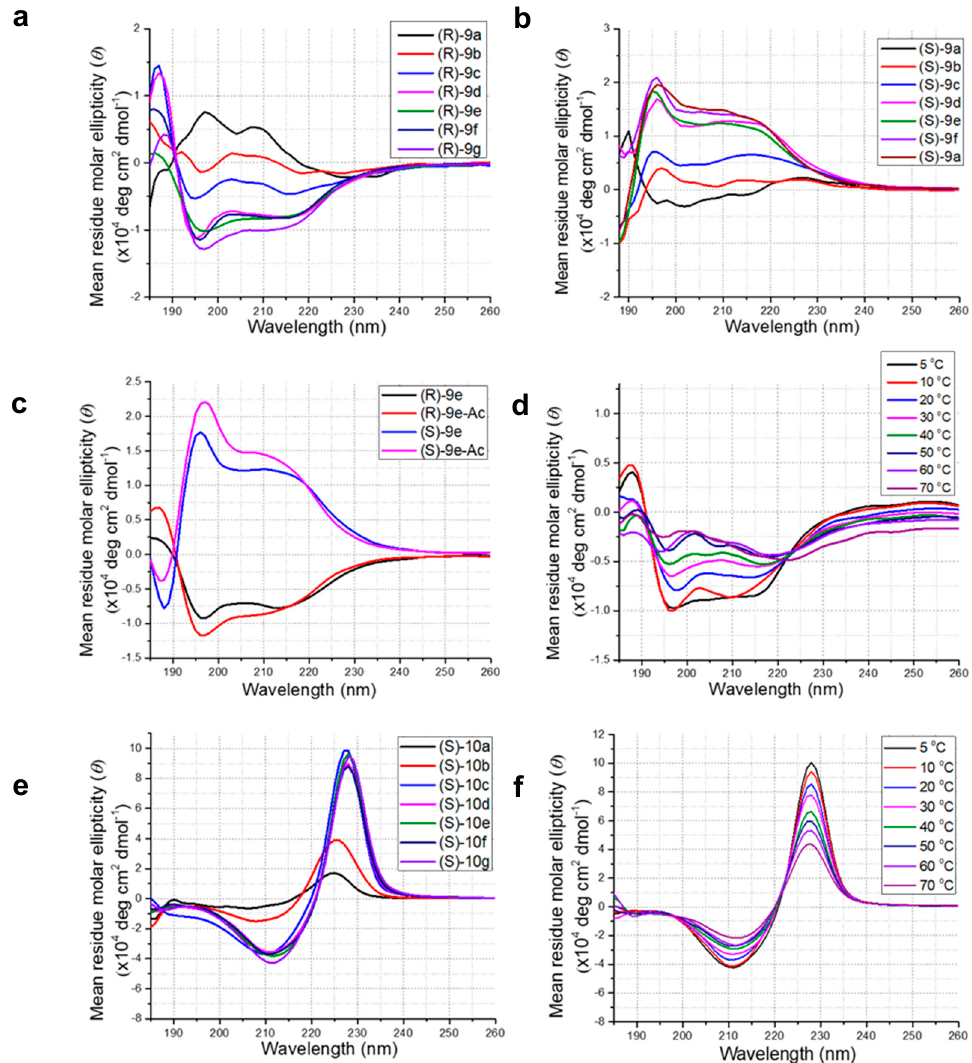
Figure 3. CD data; ( a ) CD spectra of ( R )-form of N -benzylated β -ABpeptoid oligomers ( R ) -9a – g in acetonitrile (60 μ M), ( b ) CD spectra of ( S )-form of N -benzylated β -ABpeptoid oligomers ( S ) -9a – g in acetonitrile (60 μ M), ( c ) CD spectra of ( S )- and ( R )-forms of N -benzylated β -ABpeptoid hexamers with and without N -acetyl in acetonitrile (60 μ M). ( d ) CD spectra of ( R)-9e at 5 − 70 °C in acetonitrile (60 μ M), ( e ) CD spectra of ( S )-form of N -napthylmethyl β -ABpeptoid oligomers ( S ) -10a – g in acetonitrile (60 μ M), ( f ) CD spectra of ( S )-form of N -napthylmethyl β -ABpeptoid ( S ) -10g at 5–70 °C in acetonitrile (60 μ M).